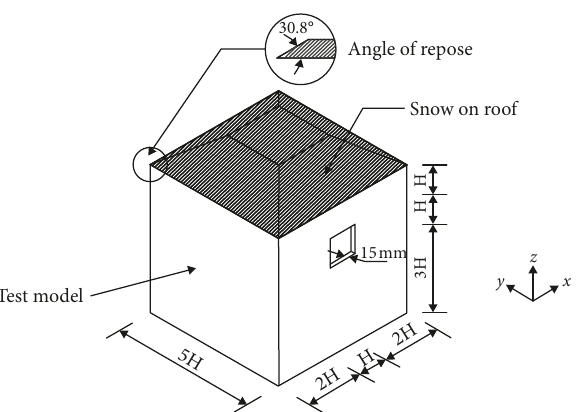
Figure 7: Single-holed test model.